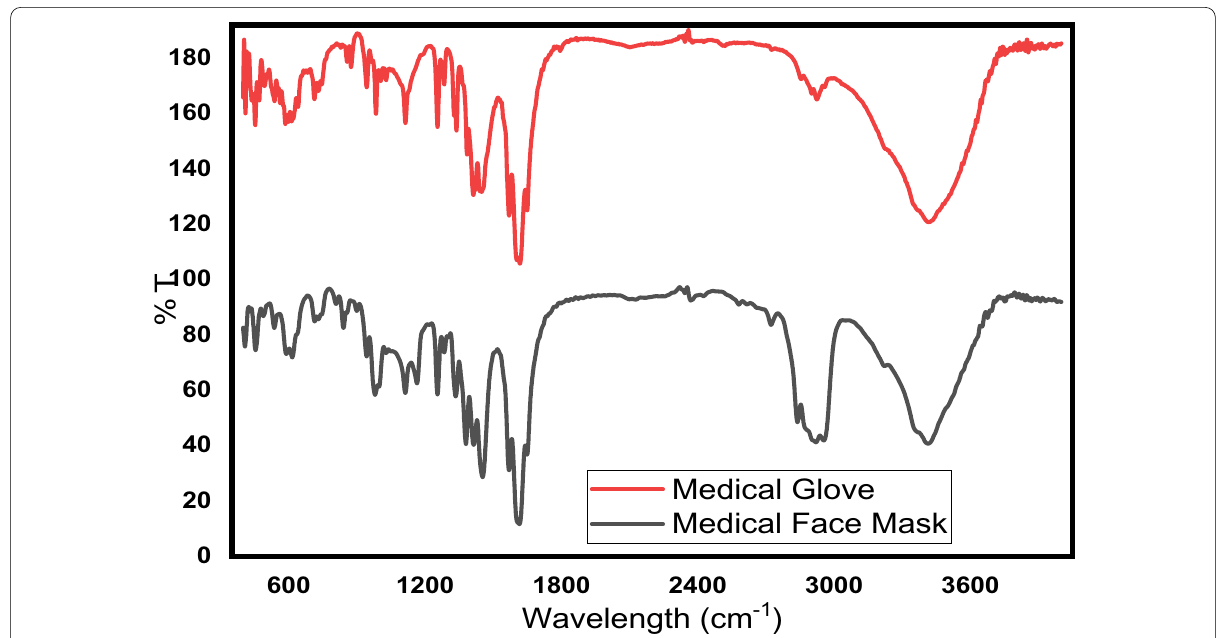
Fig. 2 Infrared Fourier transform spectrum absorption bands of medical face mask and